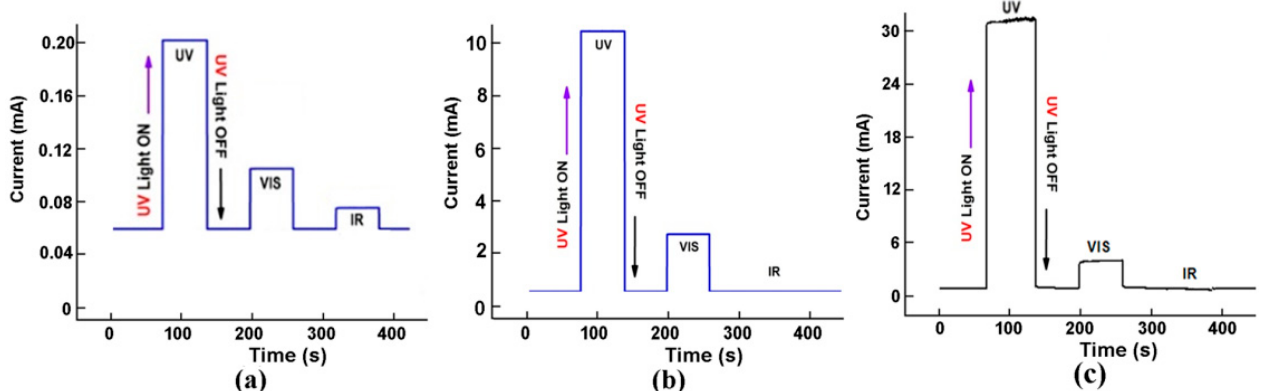
Figure 14. Relaxation of photocurrent measured at 300 K with illumination at different wavelengths for a photodetector with a Zn 80 Mg 20 O film ( a ), a photodetector with n-Zn 90 Mg 10 O/n-Zn 60 Mg 40 O films ( b ), and a photodetector with n-Zn 85 Mg 15 O/n-Zn 65 Mg 35 O films ( c ).